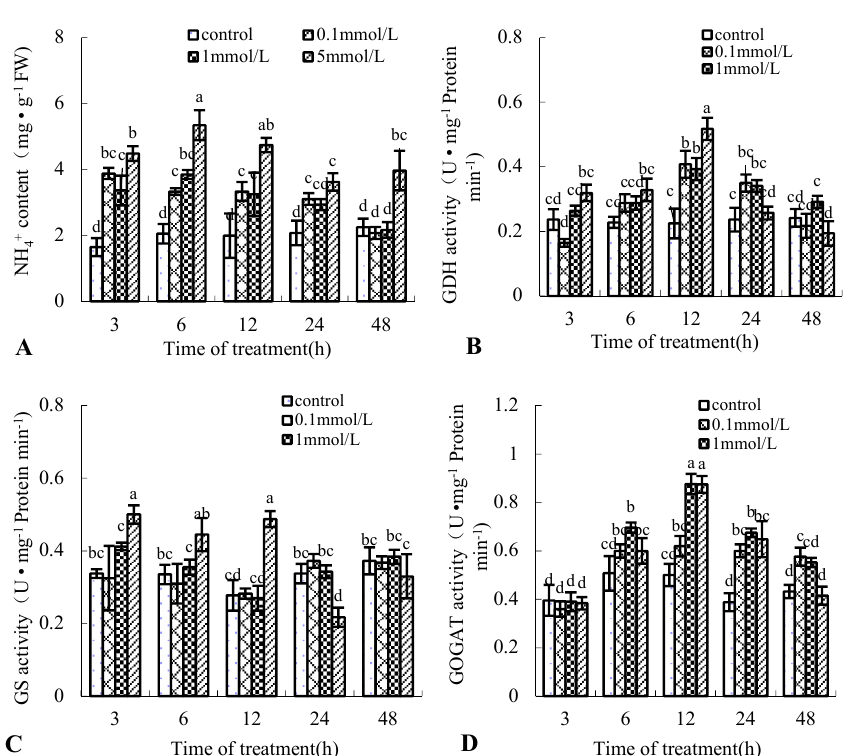
Figure 5. Effect of Put on the content of NH 4+ and its assimilation enzyme activities in suspension cells of birch. ( A ), NH 4+ content in culture medium of birch; ( B ), glutamate dehydrogenase (GDH) activity in suspension cells of birch; ( C ), glutamine synthase (GS) activity in suspension cells of birch; ( D ), glutamine-2-oxoglutarate aminotransferase (GOGAT) activity in suspension cells of birch.